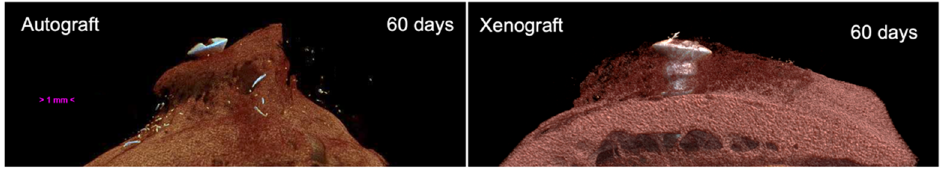
Figure 5. Micro-CT images representing the healing after 60 days in the autogenous (control) and xenogenous (test) groups.